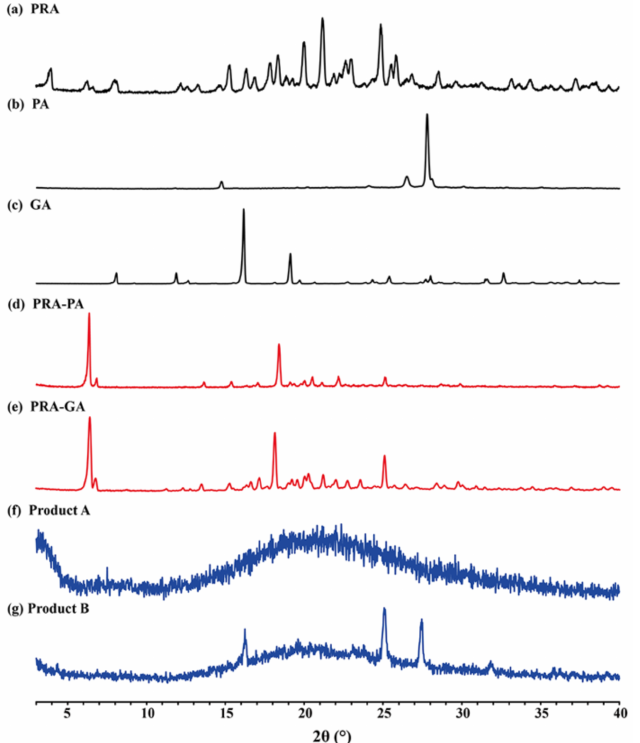
Figure 5. PXRD patterns of cocrystals PRA-PA and PRA-GA and the corresponding API and CCF ( a – e ) and thermal phase transformation products of PRA-PA-ACN ( f ) and PRA-GA-ACN ( g